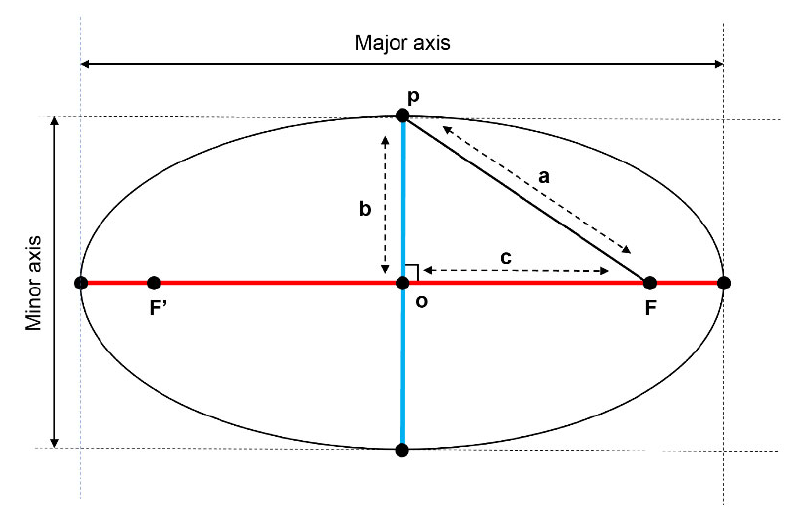
Figure 11. Characteristics of the ellipse.